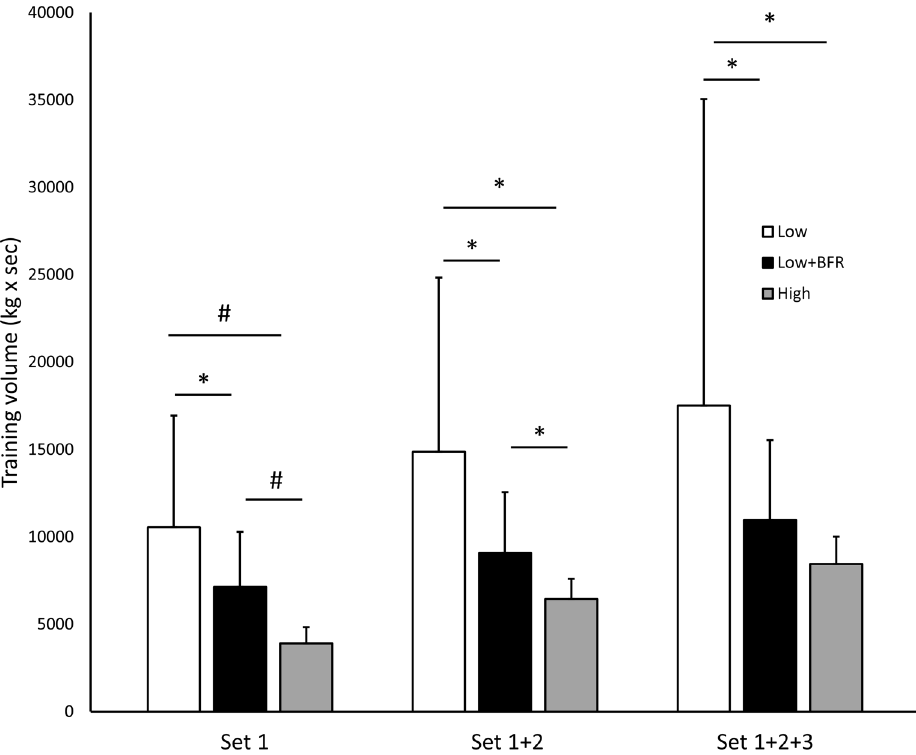
Figure 1. Accumulated training volume (kg x sec) in set 1, set 1 + 2, and set 1 + 2 + 3 in the three sessions Low, Low + BFR, and High. Data presented as mean and standard deviation. *p < 0.05, #p < 0.01.